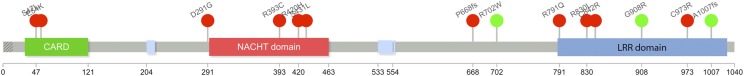
Location of risk variants in the NOD2 protein. Green dots indicate the well-established Crohn disease variants; Red dots indicate the potential risk rare variants found in the VAAST result.